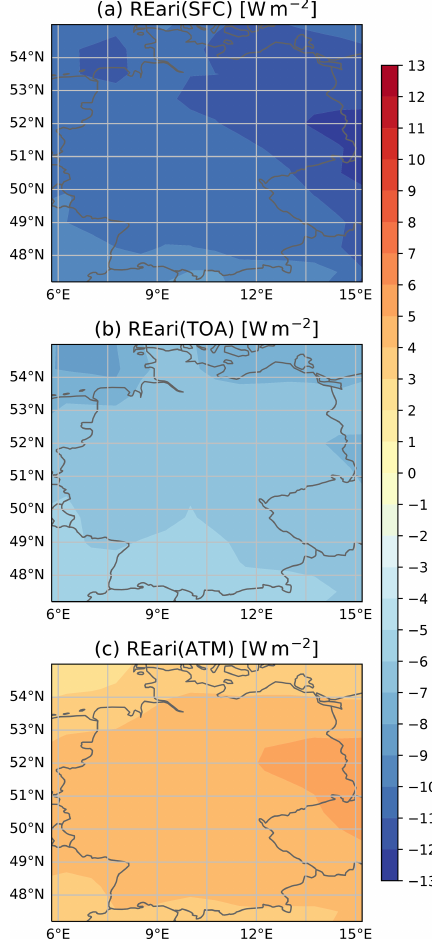
Figure 14. Annual-mean REari at the surface (SFC), TOA and to- tal atmosphere (ATM) over Germany. The simulation is conducted with the T–CARS